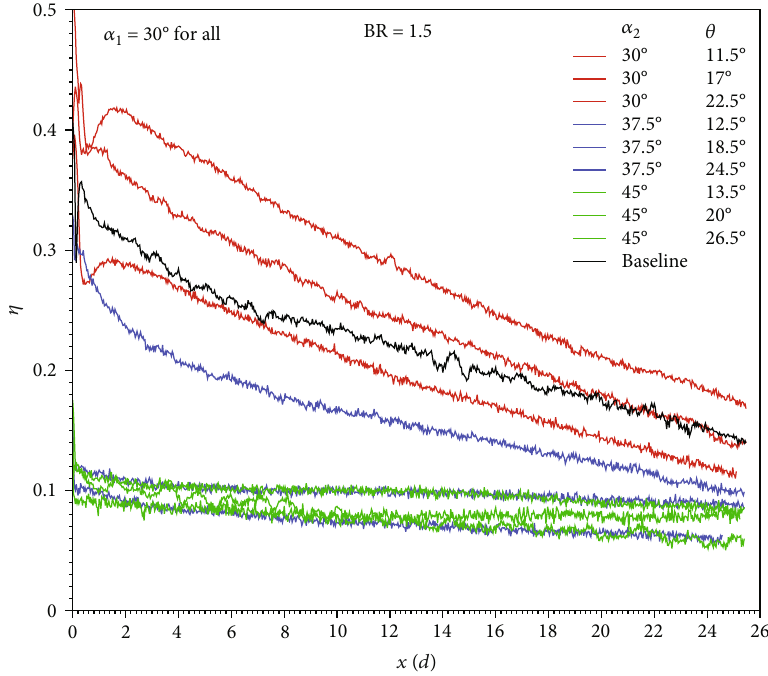
Figure 27: Comparison of streamwise (laterally averaged) fi lm e ff ectiveness variations for all geometries at BR = 1 : 5